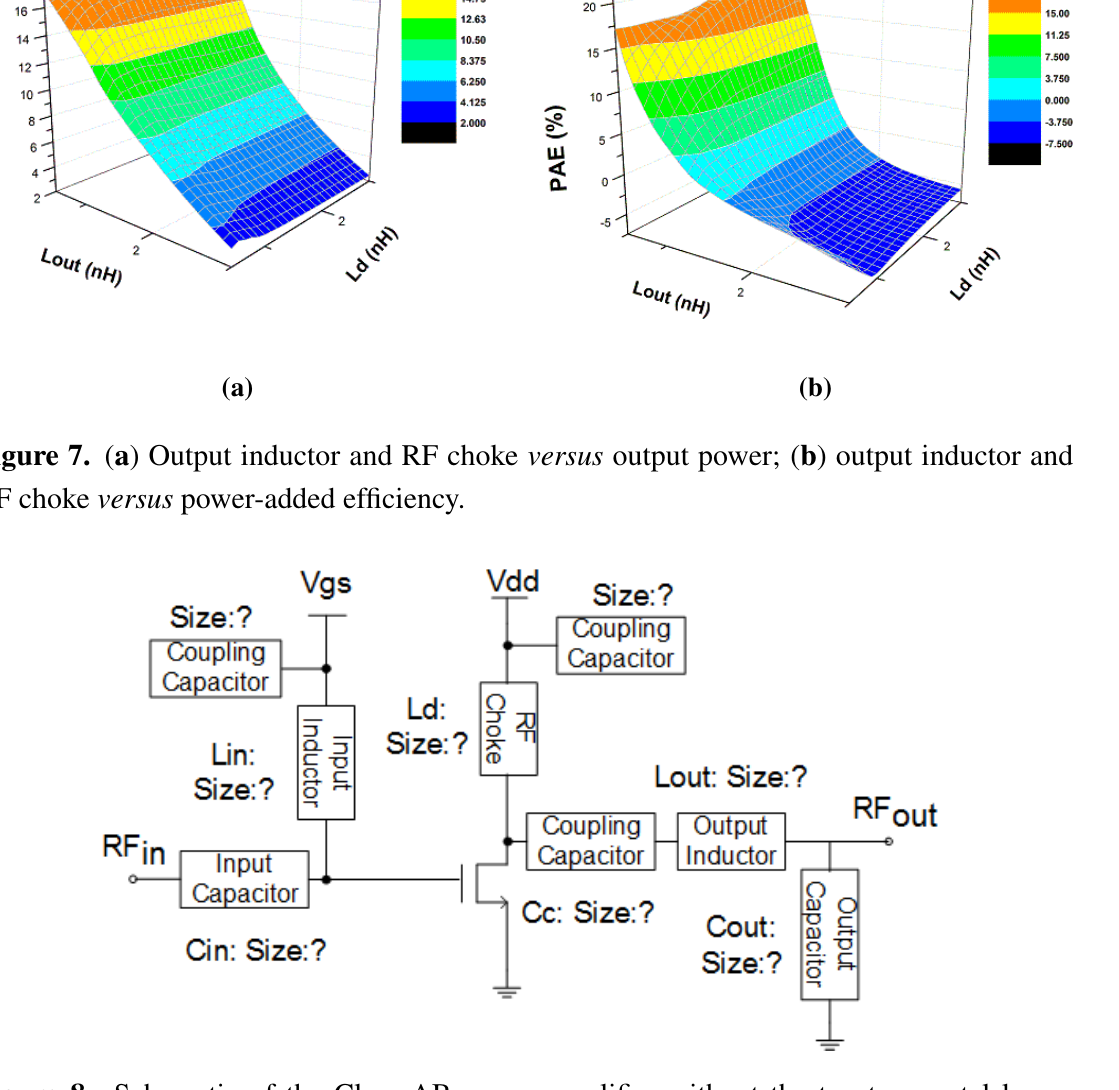
Figure 8. Schematic of the Class AB power amplifier without the top two metal layers (missing inductors and